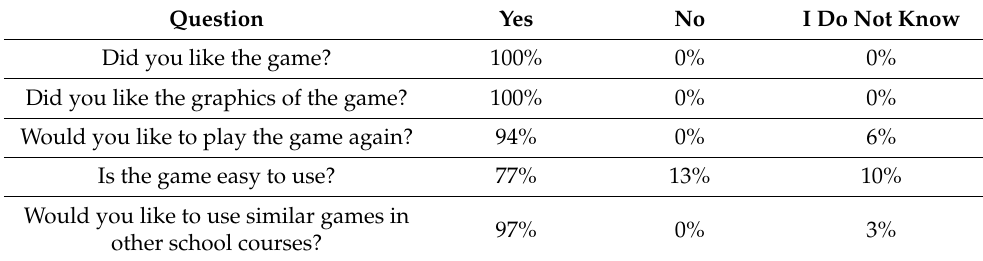
Table 4. Evaluation of the educational game.